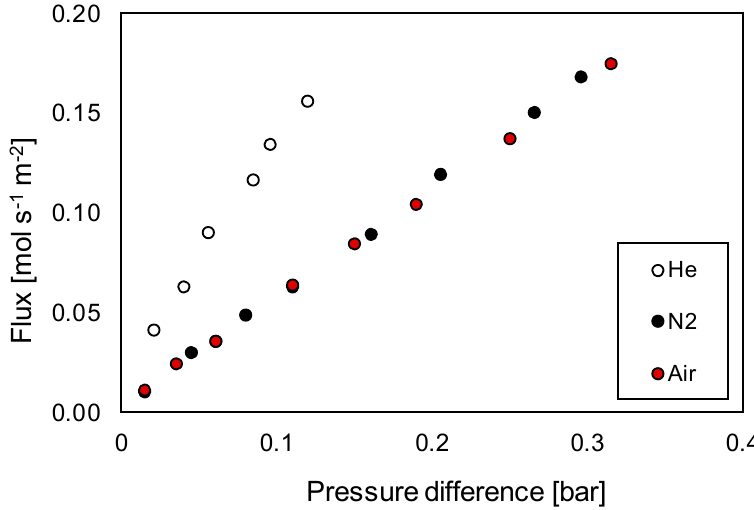
Figure A1. Flux of the symmetric MgO porous membrane plotted against the retentate–permeate pressure difference when different gases were fed in the retentate side. The experiments were carried out at 800 °C with a permeate pressure of 2 bar. The membrane used was the one described in Table 4.